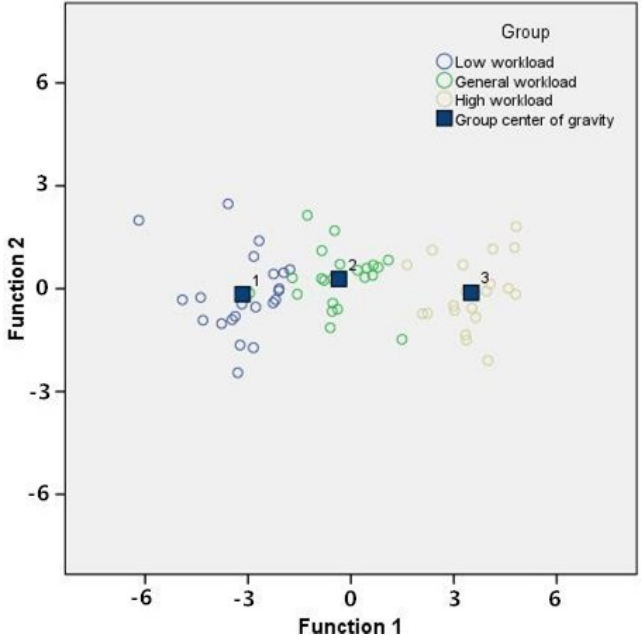
Figure 2. Typical discriminant function analysis results.